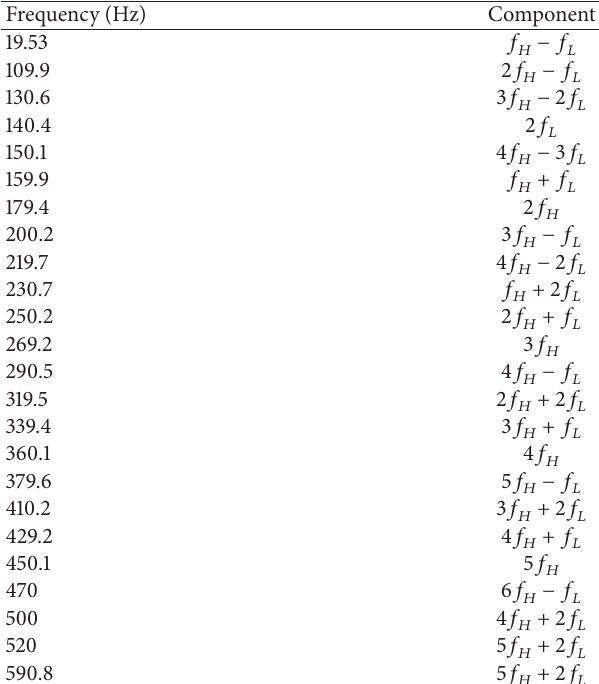
Table 1: The vibration frequency spectrum component analysis of outer